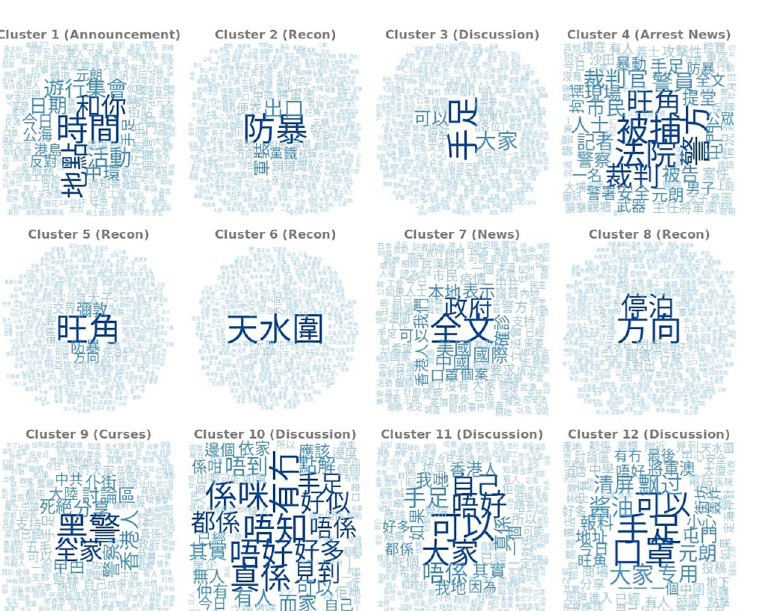
Fig 4. Wordclouds corresponding to 12 topic clusters.